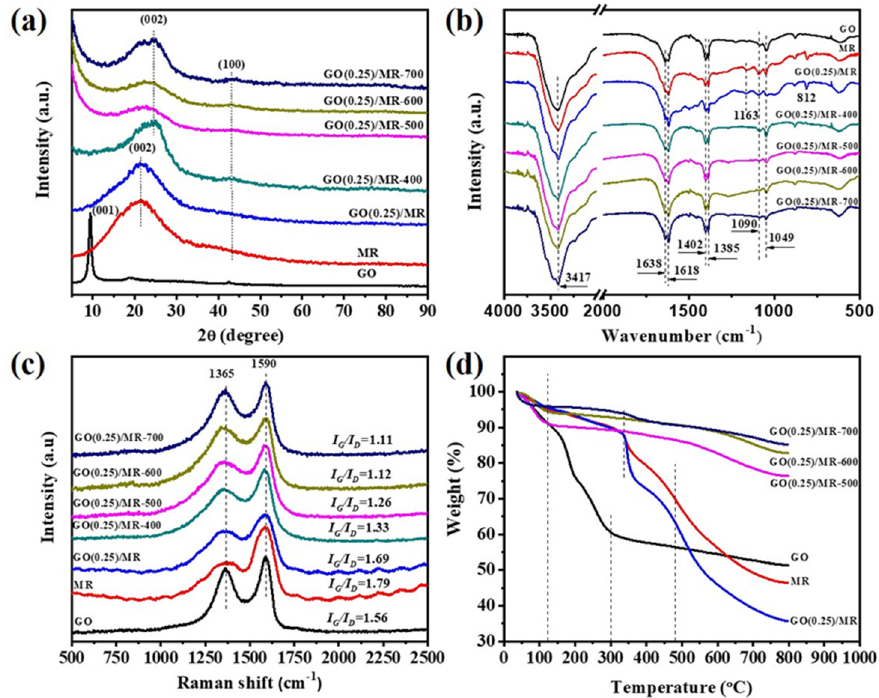
Figure 4. ( a ) XRD, ( b ) FTIR, ( c ) Raman patterns and ( d ) TGA curves of GO, MR, GO(0.25)/MR and GO(0.25)/MR-derived nitrogen-rich porous carbon materials obtained at different activation temperature.